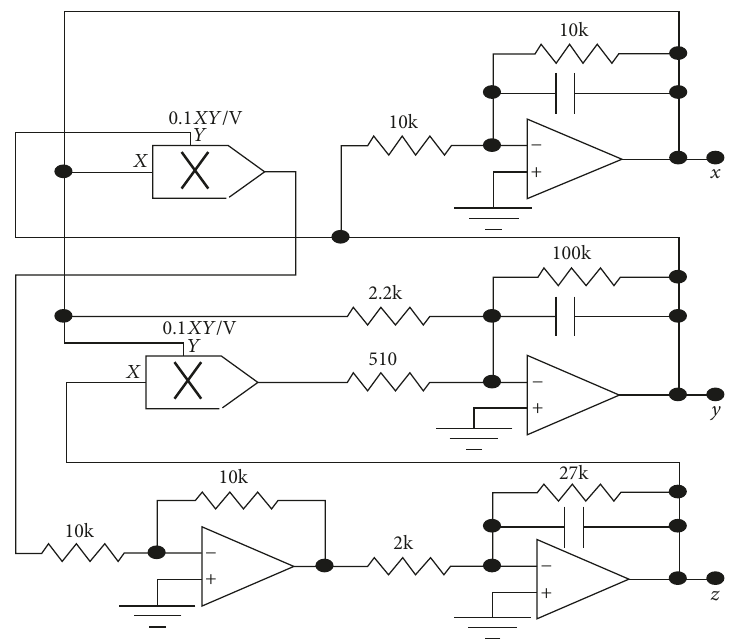
Figure 3: Lorenz-like chaotic circuit of system (2) with reduced number of amplifiers.